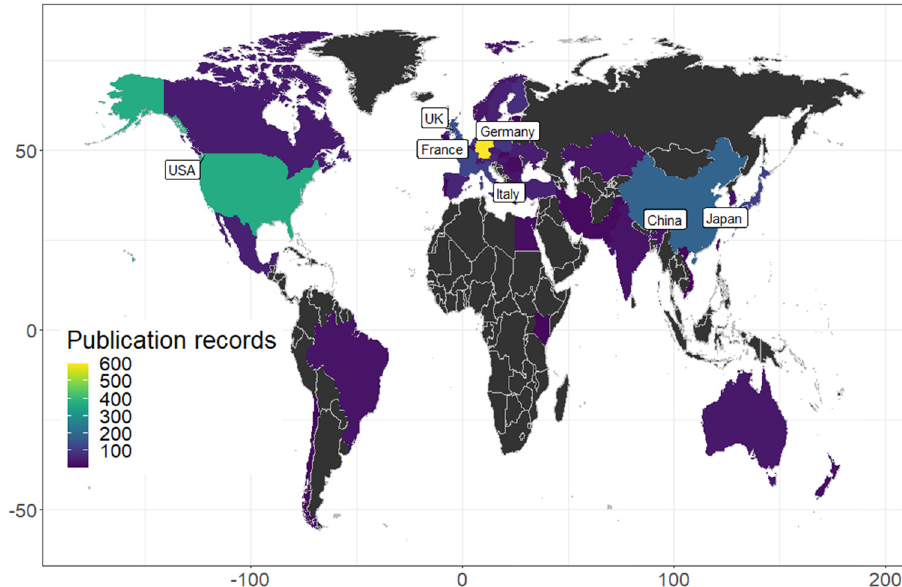
Figure 4: Distribution map of publication records by countries, authored by Russian authors with foreign co - authoring, from 1992 to 2020. Source: Own calculation using R software 4.0.2 ( 2021 ) based on the data aggregated by the Clarivate Analytics, WoS Core Collection ( 2021 )